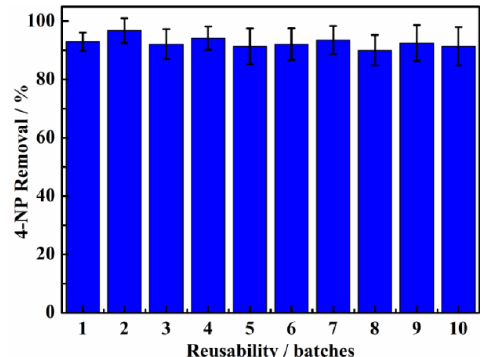
Figure 8. Reusability for the reduction of 4-NP catalyzed by the as-prepared AuNPs/BC-poly(HEMA).